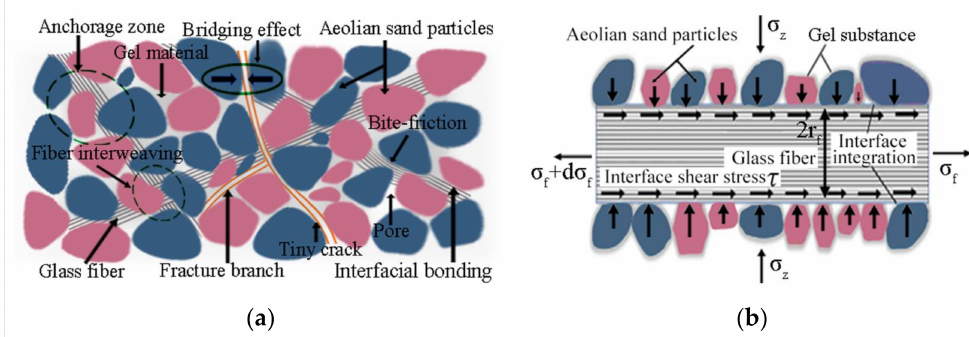
Figure 12. Interface action diagram of cement-fiber solidified aeolian sand. ( a ) Interface model of cement-fiber-solidified aeolian sand; ( b ) Force diagram of fiber